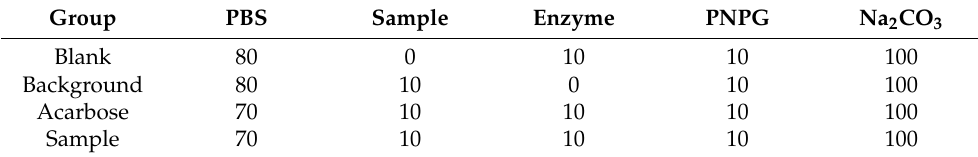
Table 1. Sample solution addition ( µ L) of each